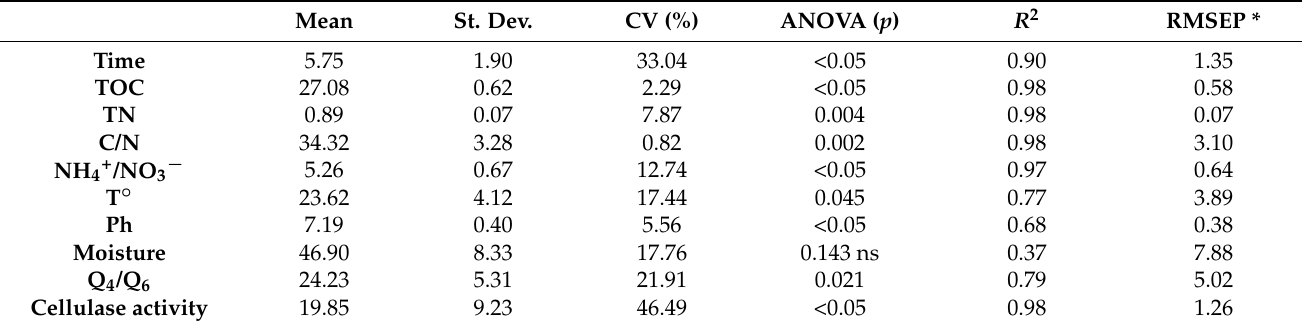
Table 5. Summary statistics of compost analytical parameters and Infrared spectra.